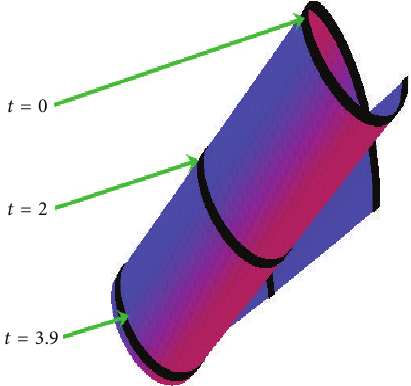
Figure 11: The curvature of the family of curves 𝐶 𝑡 for 𝑠 ∈ [0,8] , 𝑡 ∈ [0,3] , 𝑏 = 1.5 , 𝑐